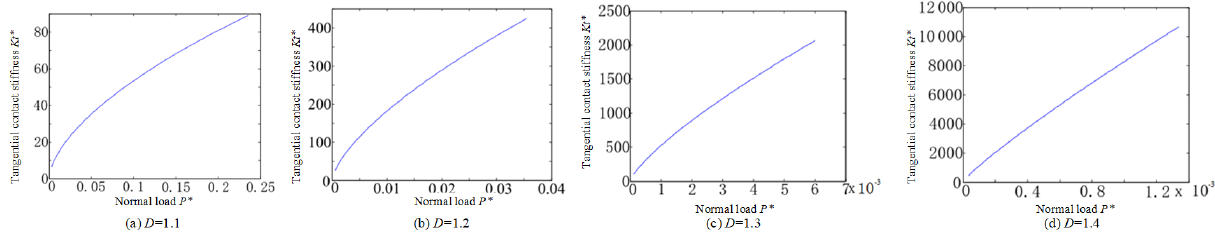
Figure 10. Effect of normal load P ∗ on tangential stiffness K ∗ t ( k = 1 . 0, φ = 1 . 0, v = 0 . 3, h = 0 . 02, G ∗ = 1 . 0 × 10 − 9